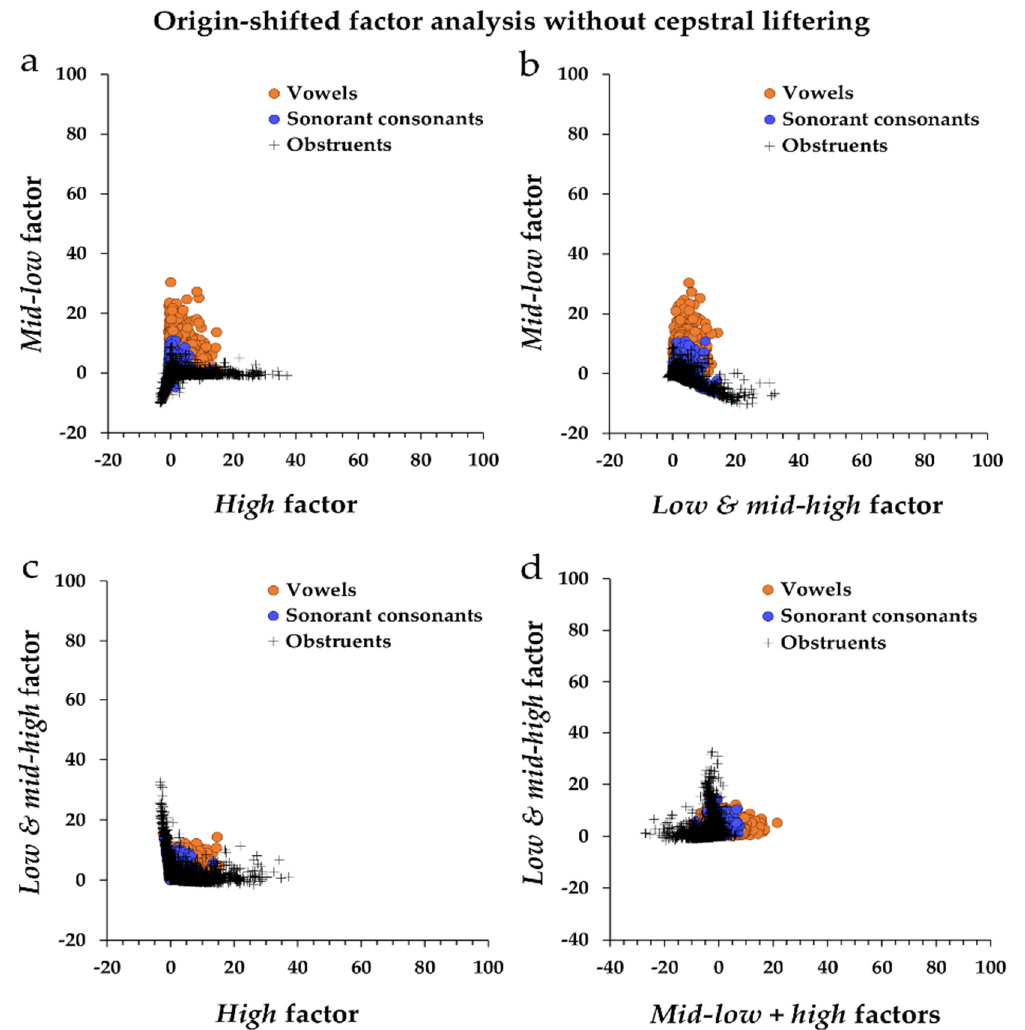
Figure 4. The distribution of factor scores by origin-shifted factor analysis without cepstral liftering. ( a – c ) represent all possible combinations of two factors out of the three factors, and ( d ) shows a two-dimensional mapping of the three factors.